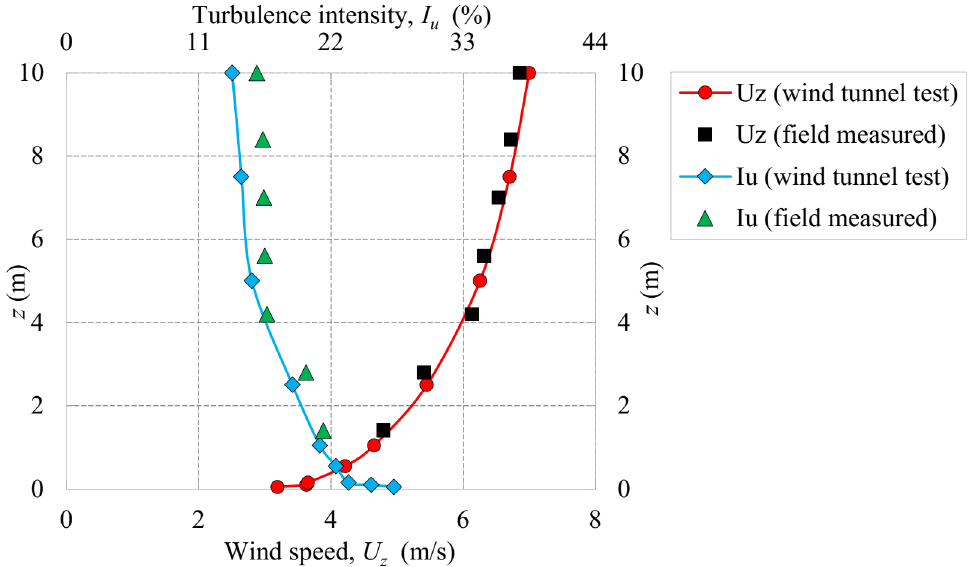
Figure 3. Wind profiles and turbulence intensities of the impurity-free